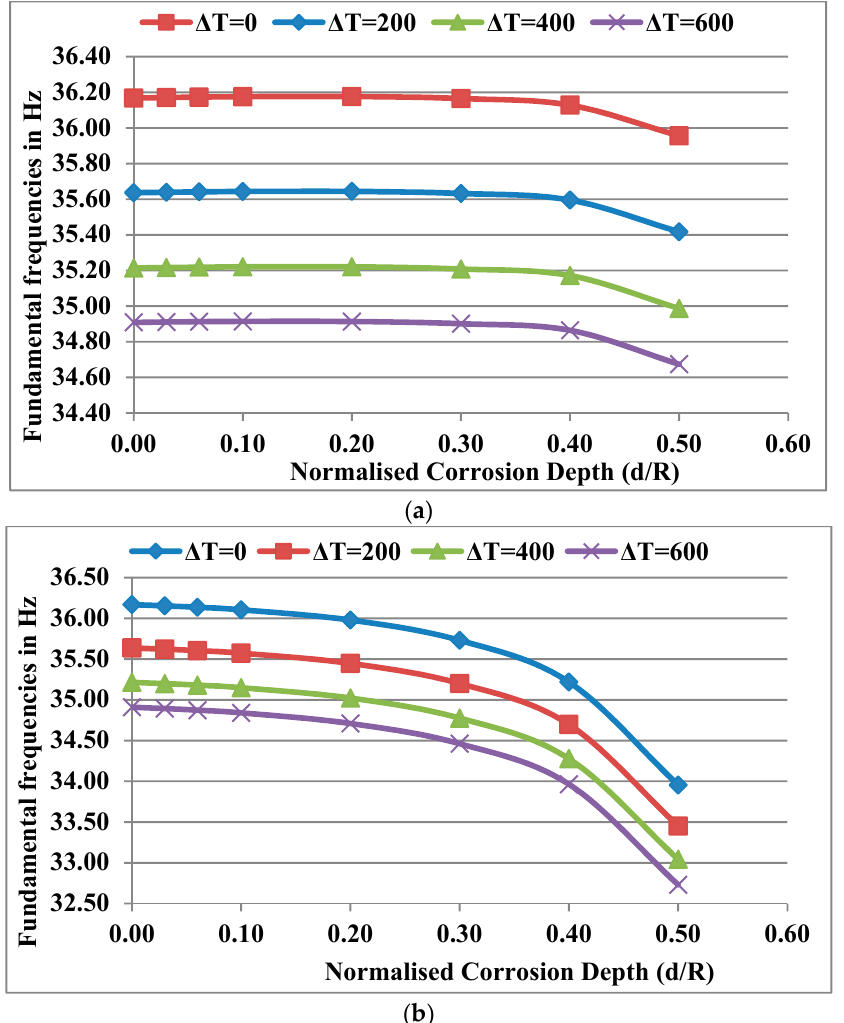
Figure 9. ( a ) Effect of d/R for different Δ T values on the fundamental frequencies of the corroded rotor system for k = 0.5, X c /L = 0.1 and L c /L = 0.02; ( b ) effect of d/R for different Δ T values on the fundamental frequencies of the corroded rotor system for k = 0.5, X c /L = 0.4 and L c /L = 0.02.